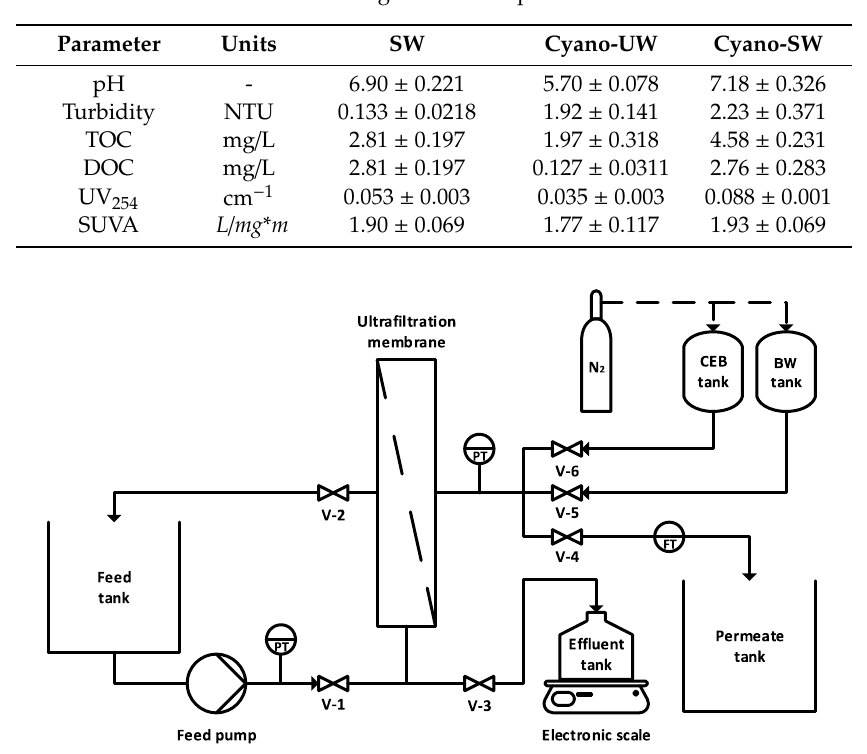
Table 1. Average feed water parameters.